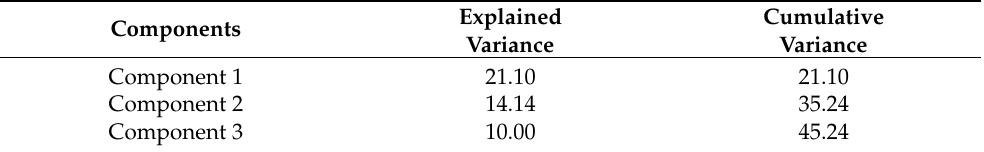
Table 6. Explained and cumulative variance of candidate principal components (%).